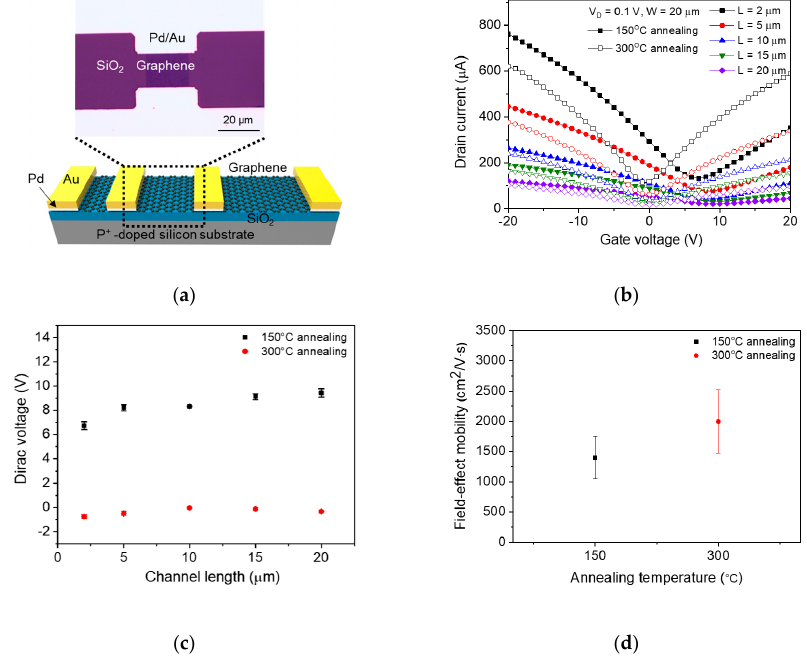
Figure 1. ( a ) Schematic and optical image of the field-effect transistor (FET)-structure graphene photodetector. ( b ) Two sets of transfer characteristics (I D –V G ) of the graphene photodetectors measured at V D = 0.1 V after 150 °C and 300 °C annealing. Channel lengths varied from 2 – 20 μ m, and channel width was fixed to 20 μ m. The error bar indicates a standard deviation. ( c ) Dirac voltage vs. channel length of the graphene photodetectors extracted from the I D –V G characteristics measured after 150 °C and 300 °C annealing. ( d ) Field-effect mobility of the graphene photodetectors after the post-annealing process. The mobility values were calculated using the maximum transconductance values and conventional field-e ff ect mobility equation